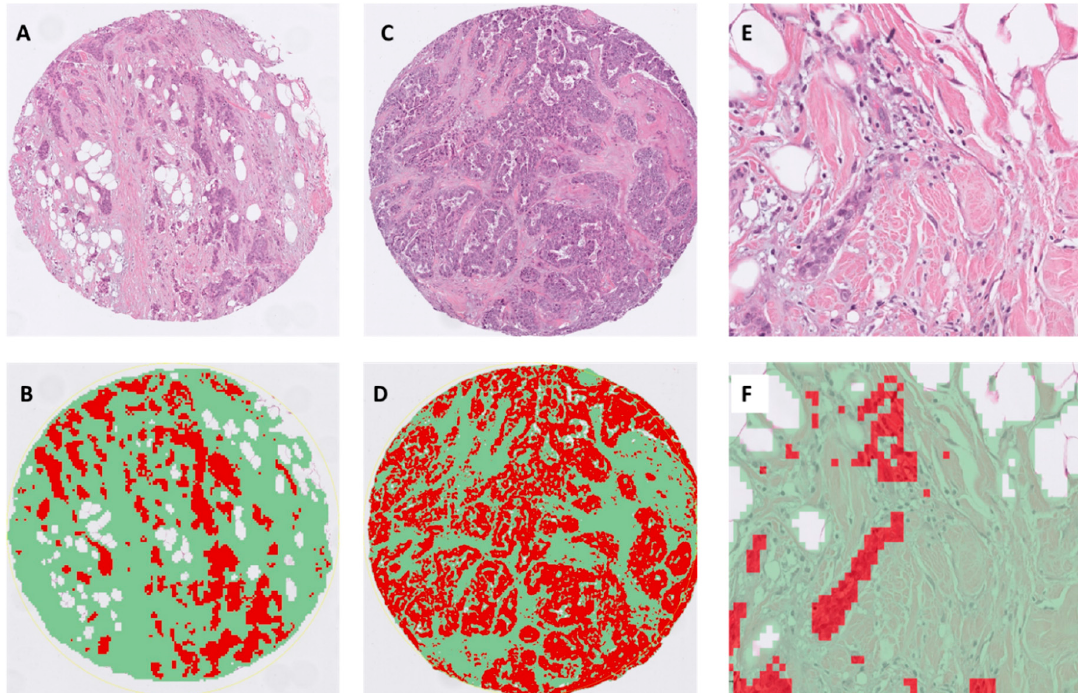
Figure 1. Representative matched H&E and segmented images of tumour epithelium (red), stroma (green) and fat (white) using the pixel classifier algorithm in QuPath. The images display examples of invasive ductal carcinoma with ( A , B ): low tumour stroma ratio (TSR) (i.e., stroma high, TSR: 0.35, × 100), ( C , D ) intermediate TSR (roughly equivalent volumes of epithelium and stroma, TSR: 0.9, × 100); ( E , F ): high power of invasive ductal carcinoma with adjacent fat with a mild infiltrate of stromal tumour infiltrating lymphocytes (TILs) (×400).